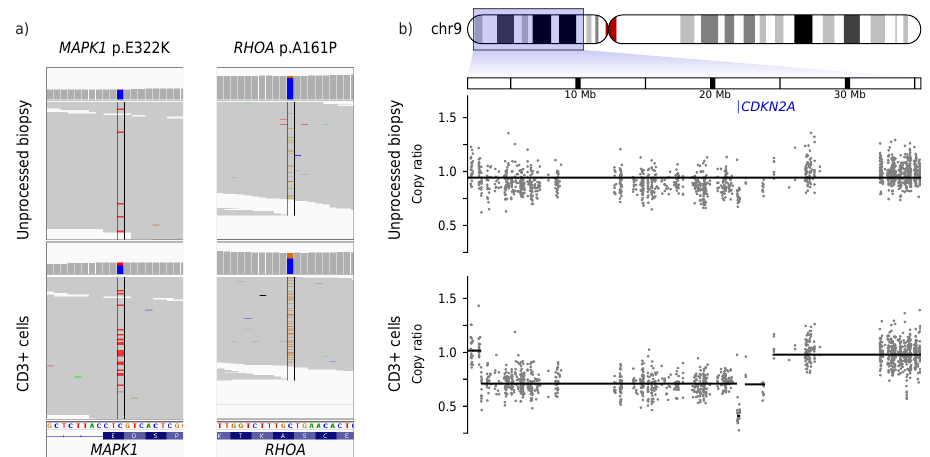
Figure 2. Somatic variant calling in an early-stage MF skin biopsy without (top) and with (bottom) enrichment of tumor cells. One skin lesion of a patient with tumor stage 1 MF was biopsied. One half (unprocessed biopsy) was used without further steps. The other half of the material was used for enrichment of CD3-positive cells (CD3+ cells). Afterwards, both halves were used for DNA isolation, WXS, and calling of somatic SNVs and CNVs. ( a ) Raw data for the somatic SNVs MAPK1 p.E322K and RHOA p.A161P where colored strips indicate variant reads diverging from the genome reference. ( b ) Raw and processed data for a deletion on chr9 leading to homozygous loss of CDKN2A . The gray dots show the copy-ratio (denoised and normalized read depth of individual exons) while the black lines depict the automatic CNV call. A copy-ratio of 1 indicates a neutral copy-number of 2 on autosomes. The genomic position of CDKN2A is marked in